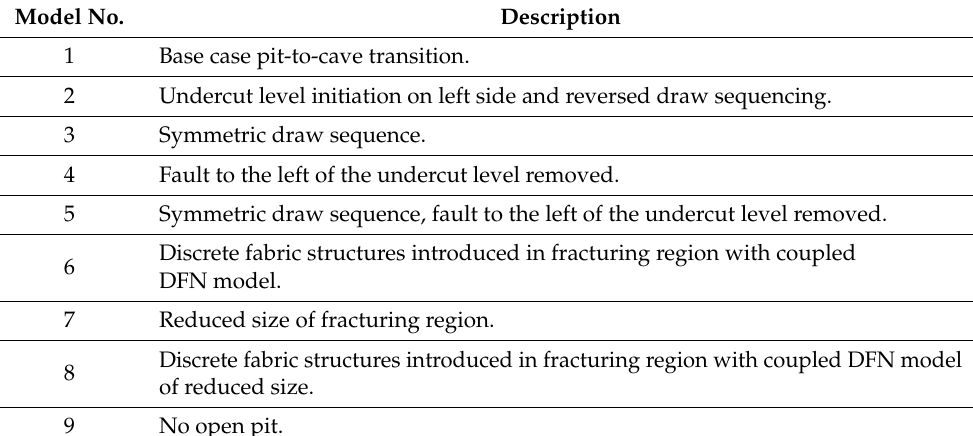
Table 2. 2D FDEM modelling scenarios. Model